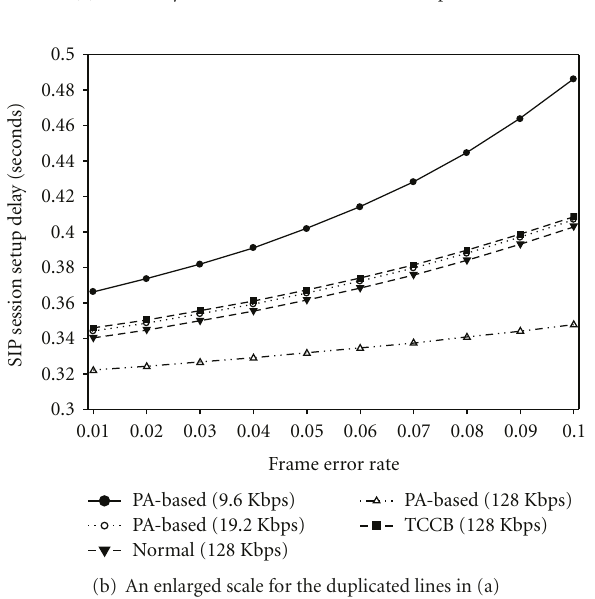
Figure 6: Comparison of delay for radio channels and session re- setup